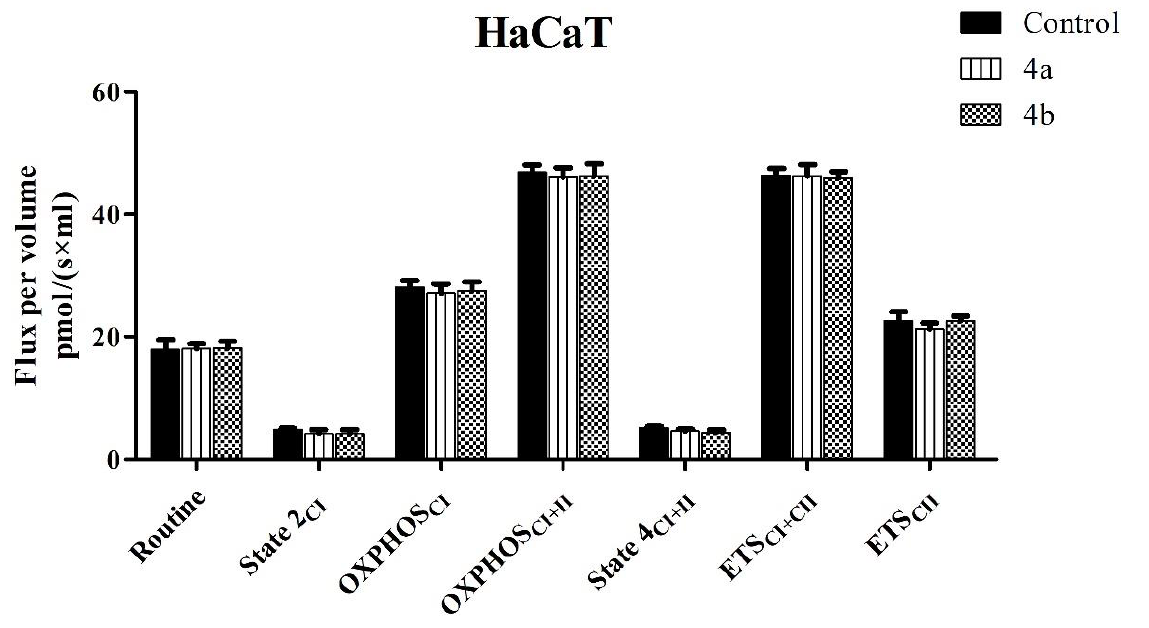
Figure 7. Rates of mitochondrial respiration measured in permeabilized HaCaT cells after treatment with compounds 4a and 4b (tested at IC 50 : 18.8 μM and IC 50 : 20.7 μM) for 48 h. All experiments were repeated five times and the results are reported as mean values ± SD. One−way ANOVA followed by Bonferroni’s post−test were used in order to identify statistical differences vs. control ( p > 0.05 implies no significant differences). Table 2. Mitochondrial respiratory rates of RPMI−9751 cells treated with compounds 4a and 4b .